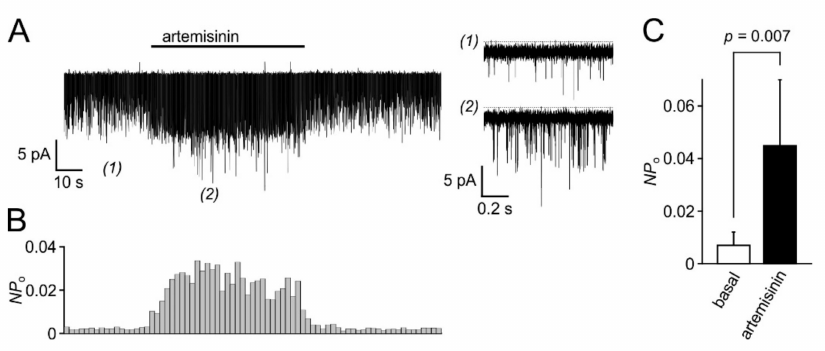
Figure 5. Channel activity induced by artemisinin in outside-out patches taken from HEK TRPC3-YFP cells. Outside-out patches were obtained from HEK TRPC3-YFP cells, and ionic currents were continuously recorded at a patch potential of –100 mV. Artemisinin (50 µ M) was applied to the bath chamber as indicated by the bar ( A , left). Short episodes before (1) and during application of artemisinin (2) are re-plotted at higher temporal resolution (right). Note that unitary current amplitudes are hardly discernible due to the very short channel opening events of TRPC3 channels. ( B ) The open probability ( P o ) for the unknown number N of channels in the patch of the experiment shown in ( A ) was calculated over 2 s bins and plotted at the same time scale. ( C ) Aggregated data (means and S.D.) of peak NP O values obtained as shown in ( B ) were obtained from 6 isolated outside-out patches before (basal) and during application of 50 µ M